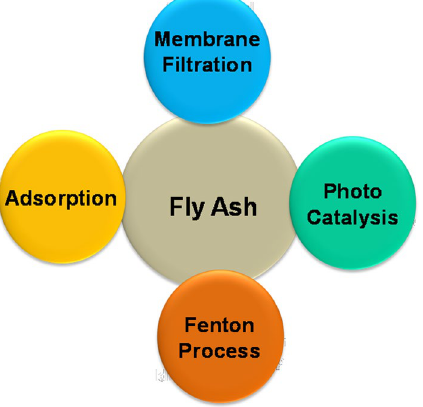
Fig. 7 Coal fly ash role in wastewater